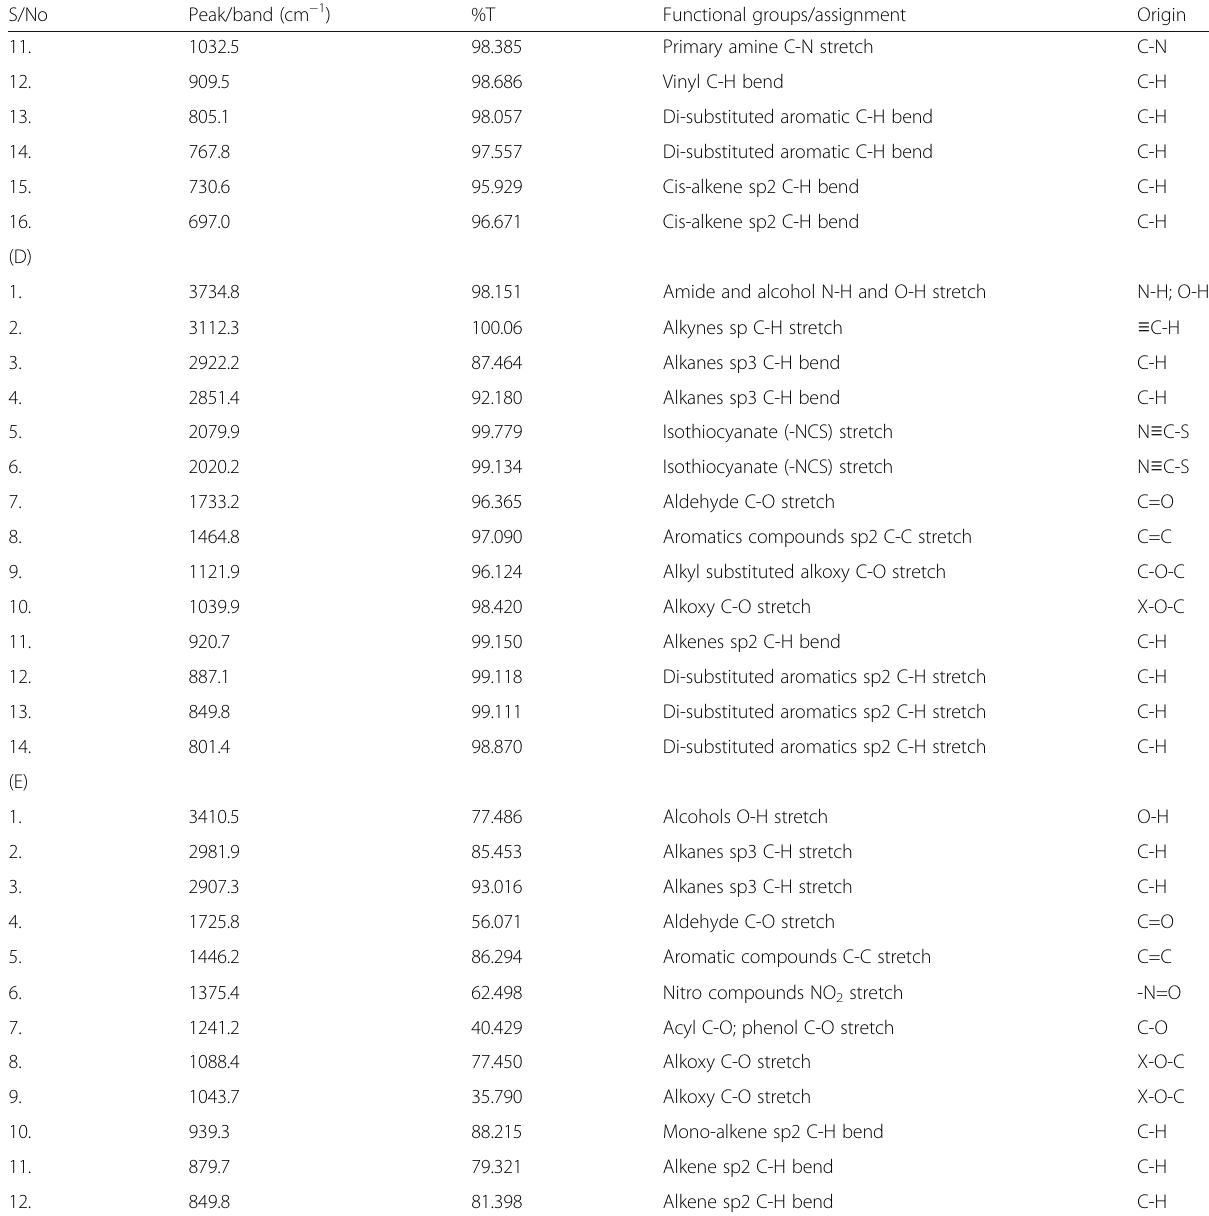
Table 3 FT-IR spectra peak values: (A) petroleum ether extract of A . occidentale , (B) ethylacetate extract of A . occidentale , (C) n - hexane extract of P . guajava , (D) petroleum ether extract of T . catappa , (E) ethylacetate extract of T . catappa